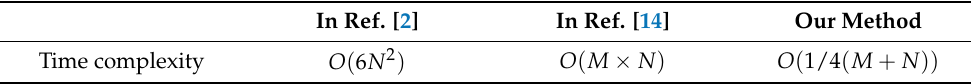
Table 7. Encryption speed test.